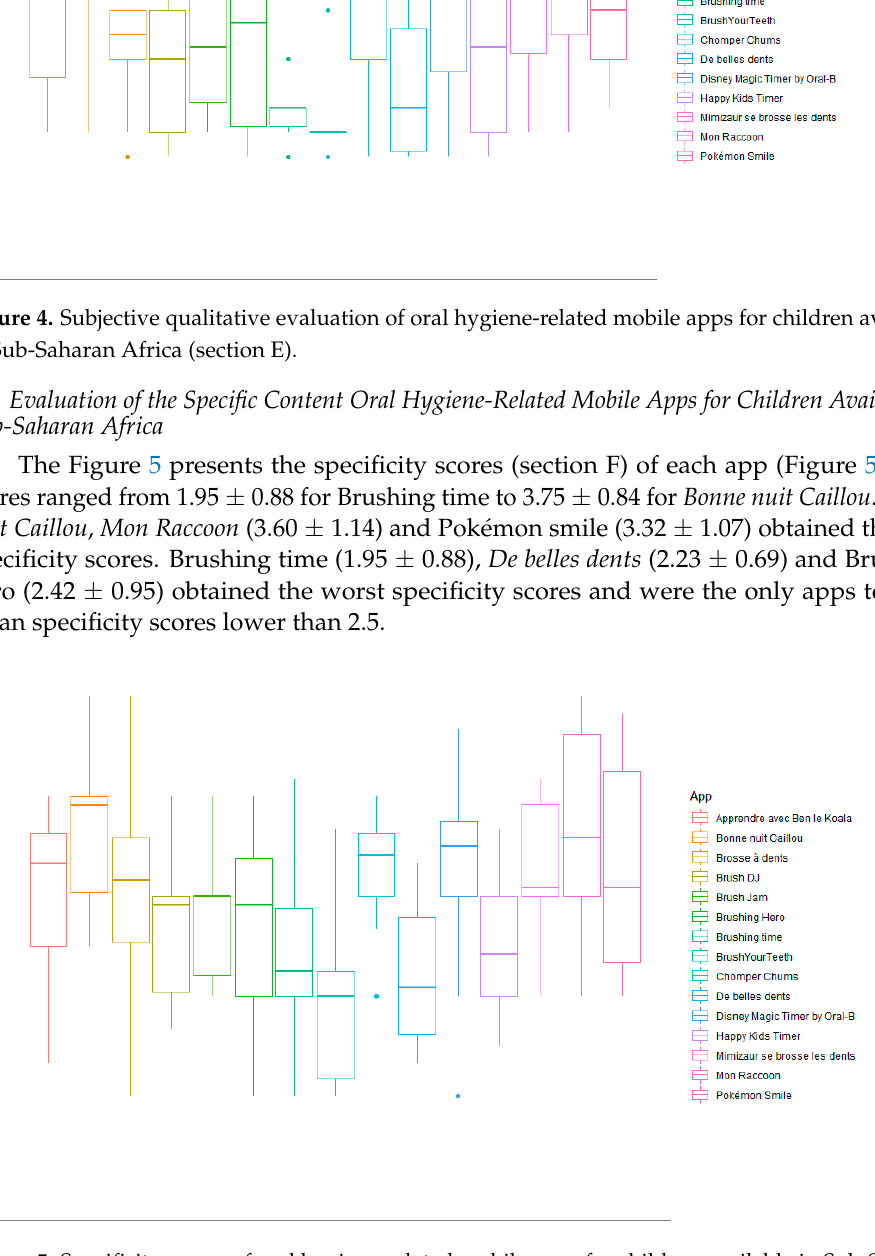
Figure 5. Specificity scores of oral hygiene-related mobile apps for children available in Sub-Saharan Africa (section F).